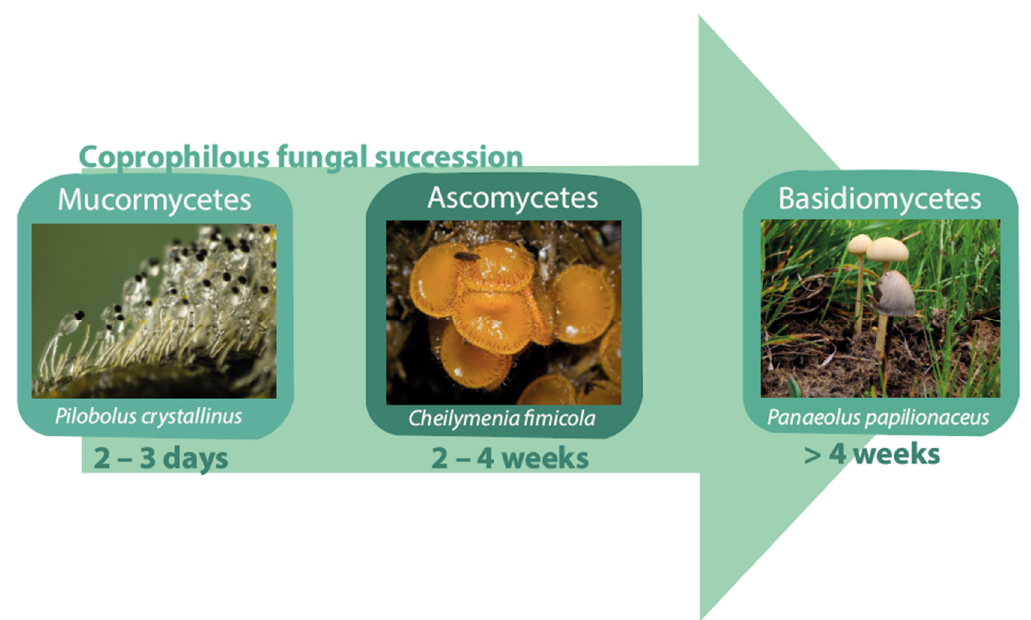
Figure 2. Coprophilous fungal class succession. Left to right: Mucormycetes image of Pilobolus crystallinus (image from [39]), Ascomycetes image of Cheilymenia fimicola (image from [40]), and Basidiomycetes image of Panaeolus papilionaceus (image from [41]).